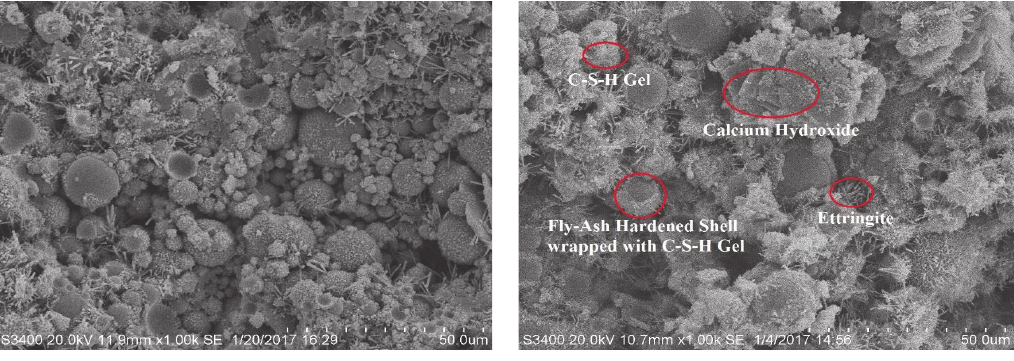
Figure 6: The SEM images of FMLSF: 1000x.